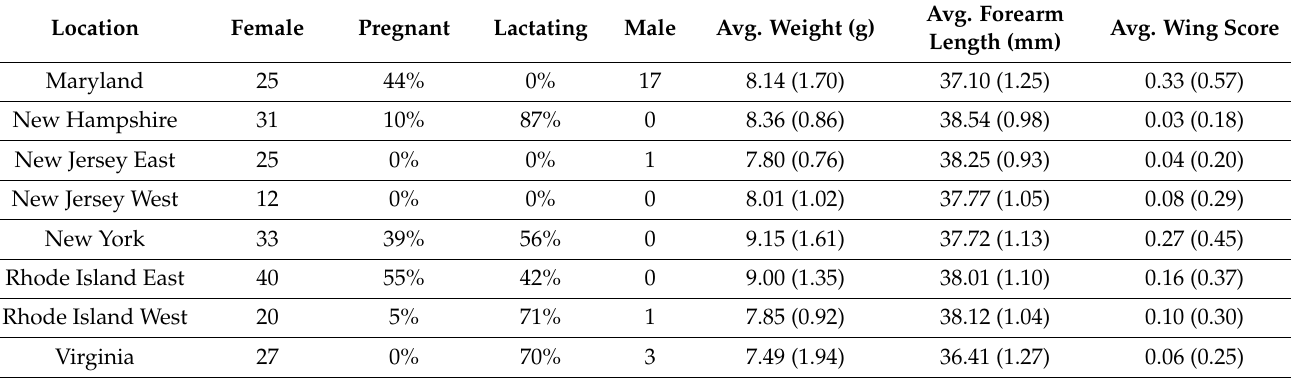
(Figure 2). U.S. Fish and Wildlife Service-mandated personal protection equipment, i.e., N95 particulate respirators (3M Corporation, St. Paul, MN, USA (Any use of trade, firm, or product names is for descriptive purposes only and does not imply endorsement by the U.S. Government)) and disposable nitrile gloves (ThermoFisher Scientific, Waltham, MA, USA), were used to remove bats from traps or nets and to process each individual for body measurements and sample collection. Gloves were changed between each bat to avoid potential cross contamination. Species, body mass (g), sex, reproductive status (pregnant, lactating, post-lactating, testes descended and non-reproductive), wing score (0–3) from WNS damage [48], and age class (adult or juvenile) based on the degree of epiphyseal-diaphyseal fusion [49] were recorded for all captured bats (Table 1). For future identification and to benefit ongoing, long-term population monitoring, each bat was fitted with a uniquely numbered 2.9 mm aluminum alloy band (Porzana, East Sussex, UK), unless previously banded. Saliva samples were collected by swabbing the oral cavity with a pediatric nasopharyngeal swab (ThermoFisher Scientific, Waltham, MA, USA), allowing the bats to chew on the swab tip for at least 10 s (Figure 2). These swab tips were placed into storage vials containing 1 mL of DNA/RNA Shield (Zymo Research, Irvine, CA, USA) and stored on ice until transported to the laboratory, where they were stored at − 80°C until RNA extraction. Table 1. Myotis lucifugus capture records from six states in the Northeast and Mid-Atlantic, USA,